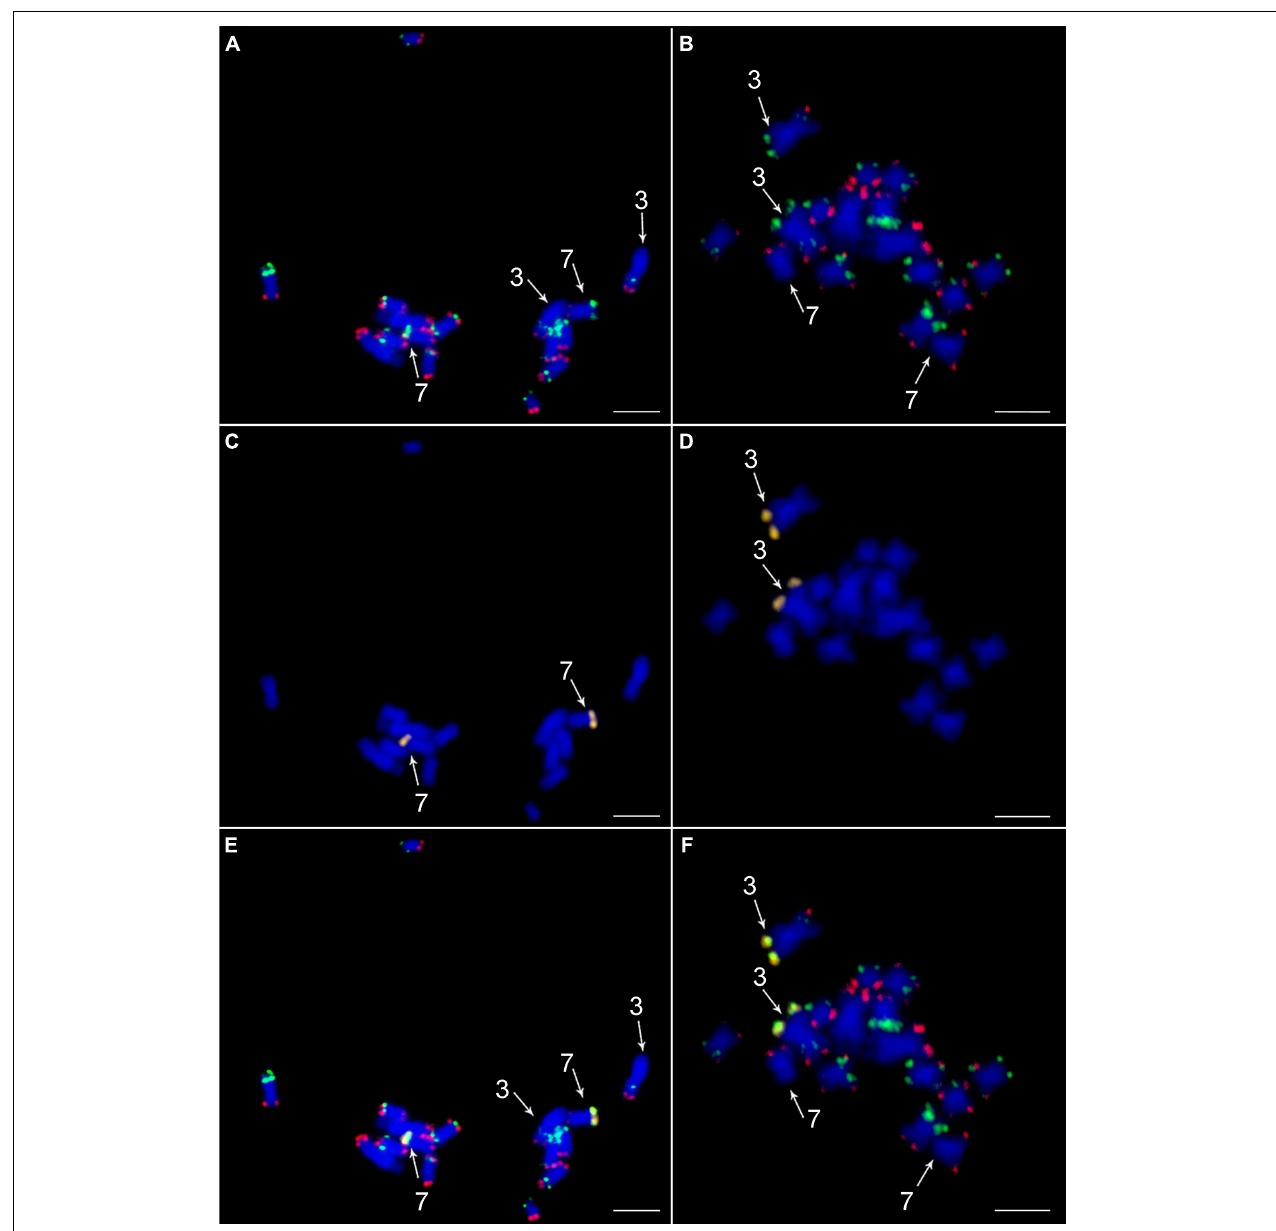
FIGURE 4 | Validation of translocation of a telomeric part of long arm of chromosome 7 to the long arm of chromosome 3 in desi type of Cicer arietinum ICC 1882. In situ localization of the two painting probes CAF-OP1 (green) in CAF-OP2 (red) on metaphase plates of (A) C. arietinum CDC Frontier (kabuli) and (B) C. arietinum ICC 1882 (desi). Localization of a probe specific to the translocated part of chromosome 7 (yellow) in the (C) kabuli and (D) desi genotypes. Colocalization of CAF-OP1 (green), CAF-OP2 (red), and a probe specific to the translocated part of chromosome 7 (yellow) on mitotic metaphase plates of the (E) kabuli and (F) desi types. Chromosomes were counterstained with DAPI (blue). Chromosomes 3 and 7 are marked by arrows. Bar = 3 µ